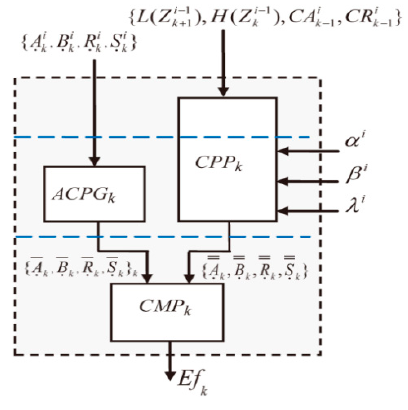
Figure 3. The logic diagram of ED k.